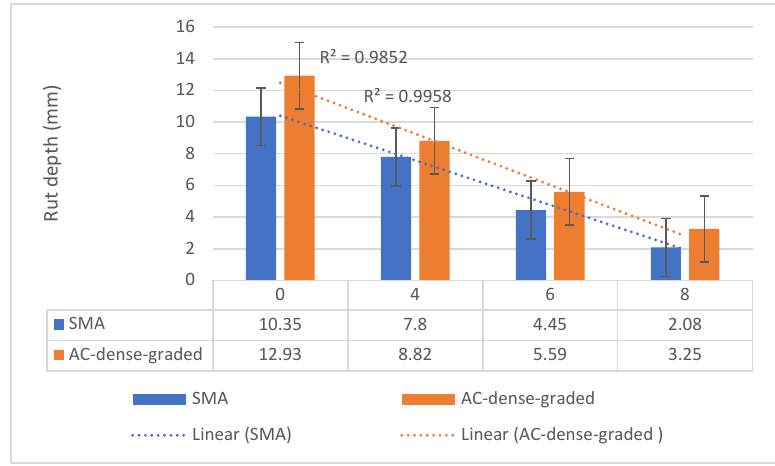
Figure 14. Rut depth of different asphalt mixtures modified with PET.